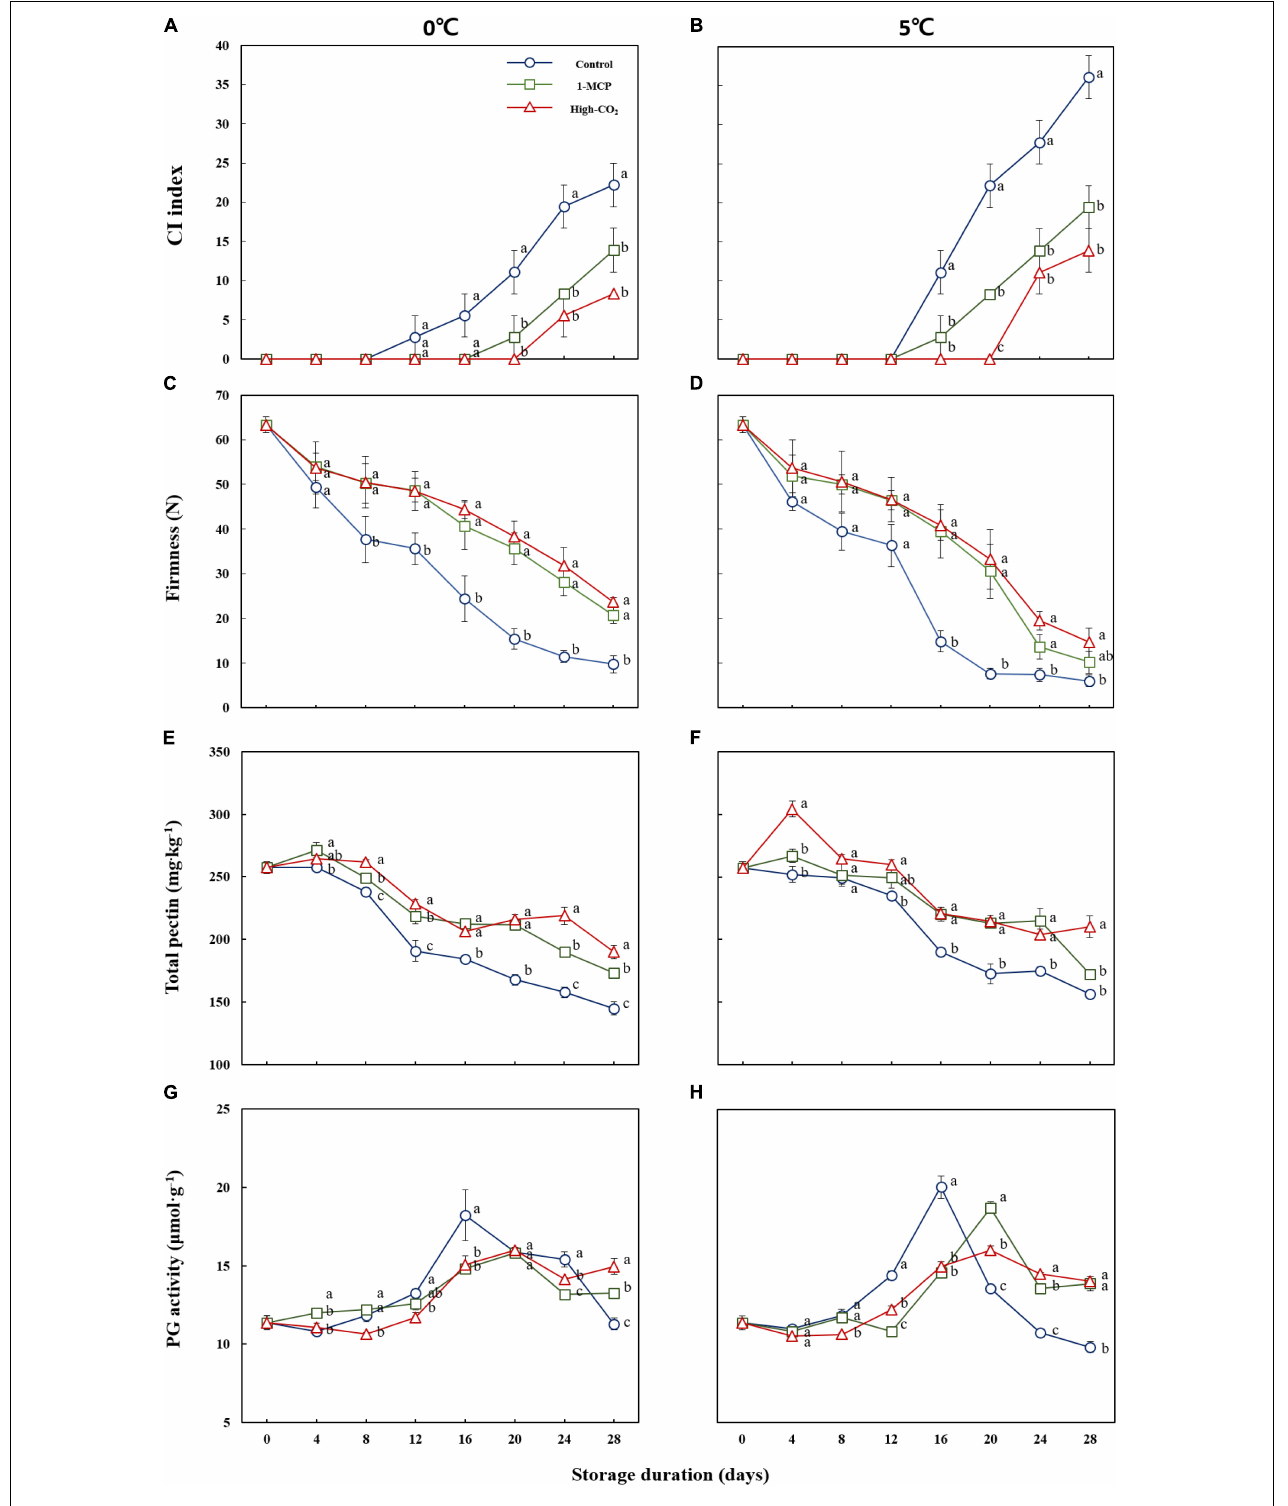
FIGURE 1 | CI index (A,B) , firmness (C,D) , total pectin (E,F) , and PG activity (G,H) of Madoka peach fruit at harvest and during storage up to 28 days at 0 and 5 ◦ C with or without prestorage treatment of CO2 and 1-MCP.